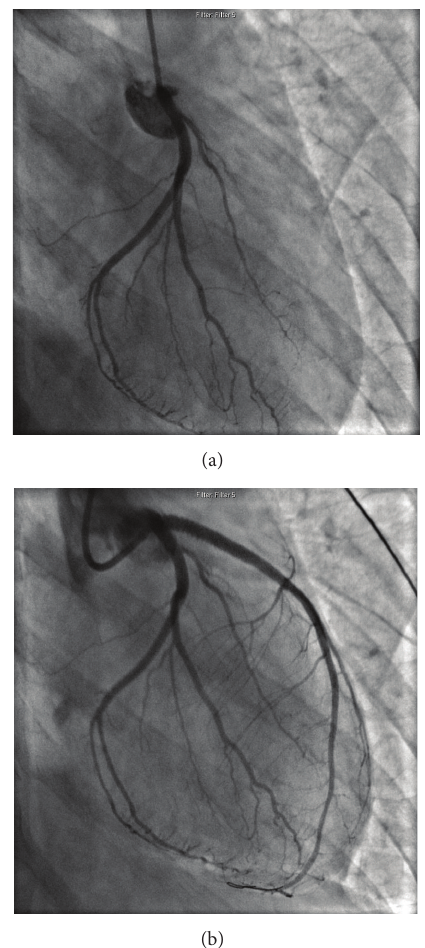
Figure 2: (a) Coronary angiogram showing total occlusion of LAD. (b) Restoration of normal flow following balloon dilation and stent deployment.